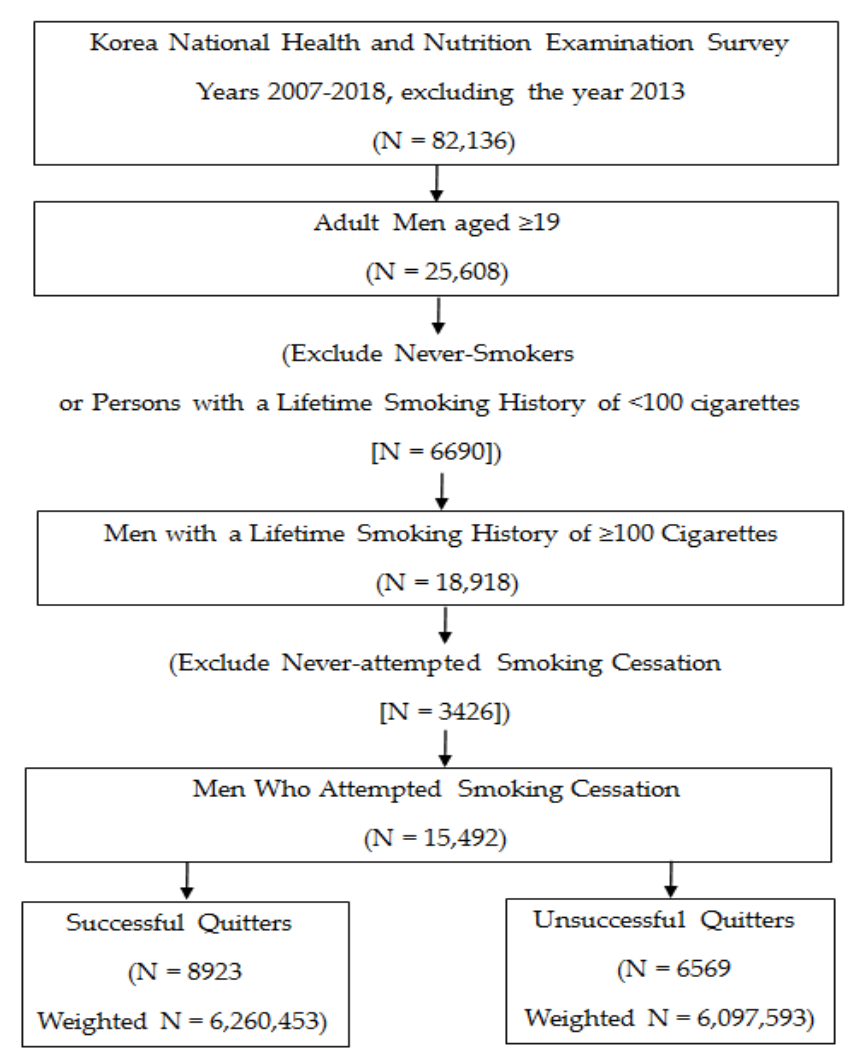
Figure 1. Flow diagram showing the inclusion and exclusion of study participants.